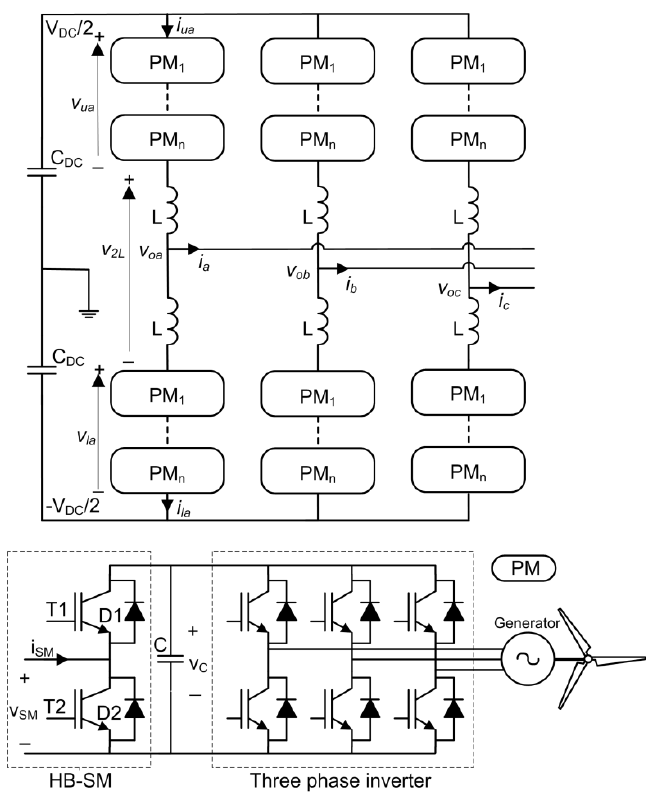
Figure 3. Proposed MMC for wind power generation, where the details of a power module (PM) including the wind generator, the generator-side converter, and the HB-SM can be seen.